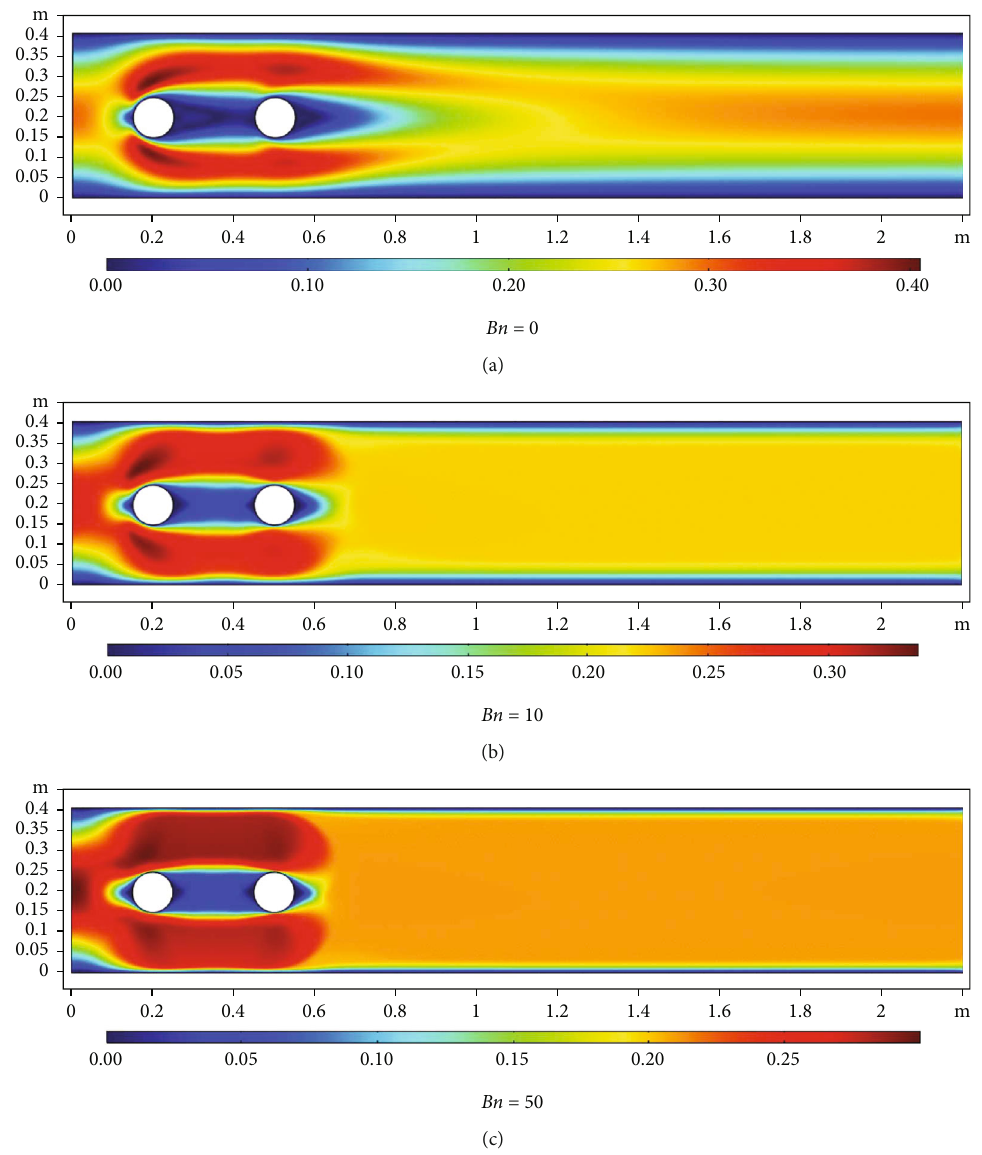
= 0 : 2 and Re = 20 : (a) Bn = 0 . (b) Bn = 10 . (c) Bn = 50 p